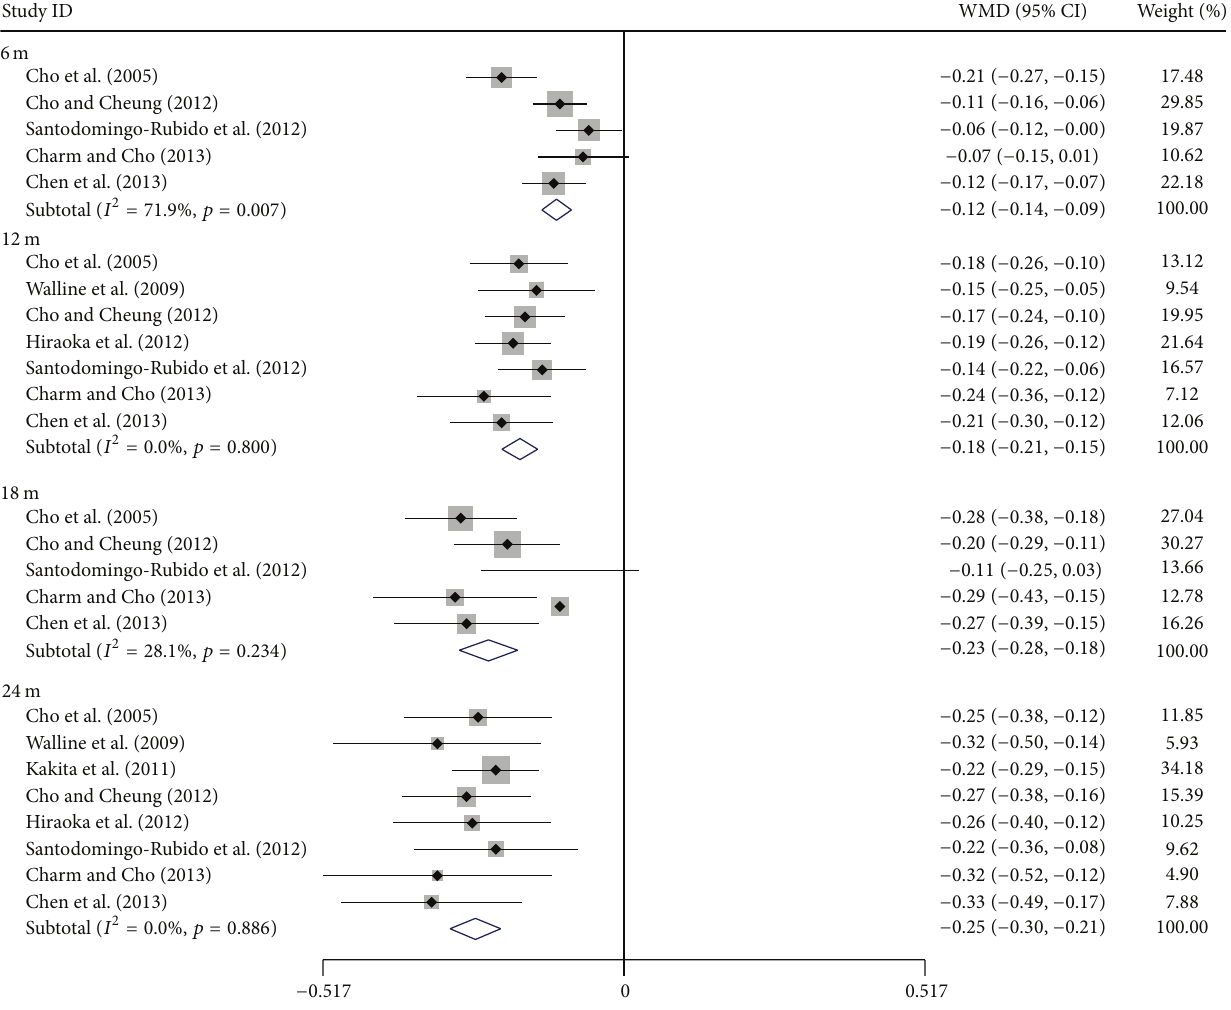
Figure 4: Mean differences of axial length change between orthokeratology and control with different treatment durations. WMD = weighted mean